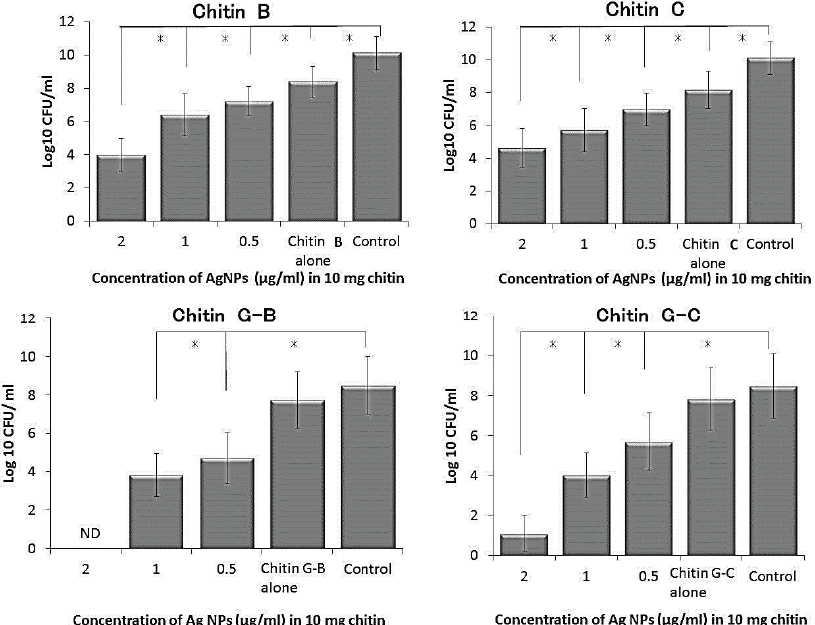
Figure 6. Antibacterial activities of chitin (B, C, G-B, and G-C)-Ag NP composites with various amounts of Ag NPs. Chitins B, C, G-B, and G-C/Ag NP composites were evaluated for their bactericidal (against E. coli ) activity in LB medium. Chitin B, C, G-B, and G-C (each 10 mg) was interacted with various concentrations of Ag NP-suspensions (0, 0.5, 1 and 2 μ g/mL) to prepare each chitin-Ag NP composite. Almost all Ag NPs in the Ag NP suspension were estimated to be adsorbed onto Chitin G-B and G-C, but only partial Ag NPs might be adsorbed onto Chitin B and C. Each composite contained various amounts of Ag NPs (10 mg) of chitin exhibited Ag NP concentration-dependent bactericidal activity in each chitin. Asterisks (*) denote statistically significant differences ( p < 0.01) as determined using a two-sample t